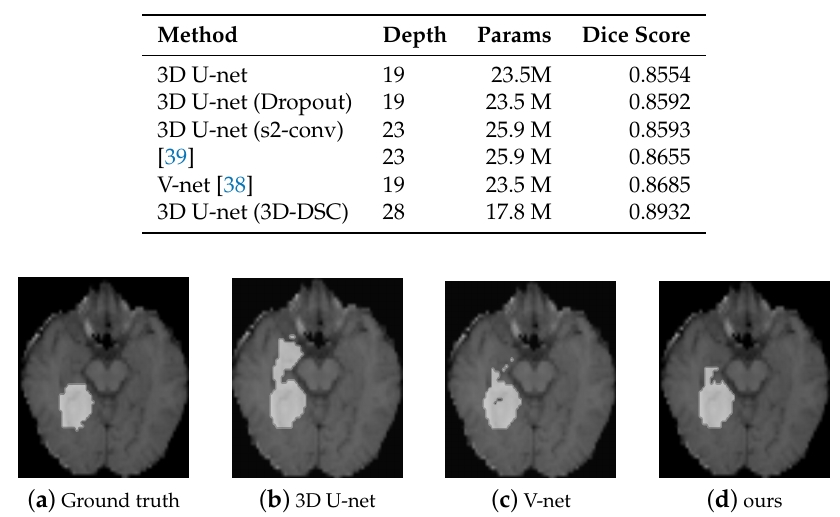
Table 6. The experimental results of the proposed method and state-of-the-art methods. We trained and evaluated these methods with the same strategy on the BRATS 2017 dataset. s2, stride 2.